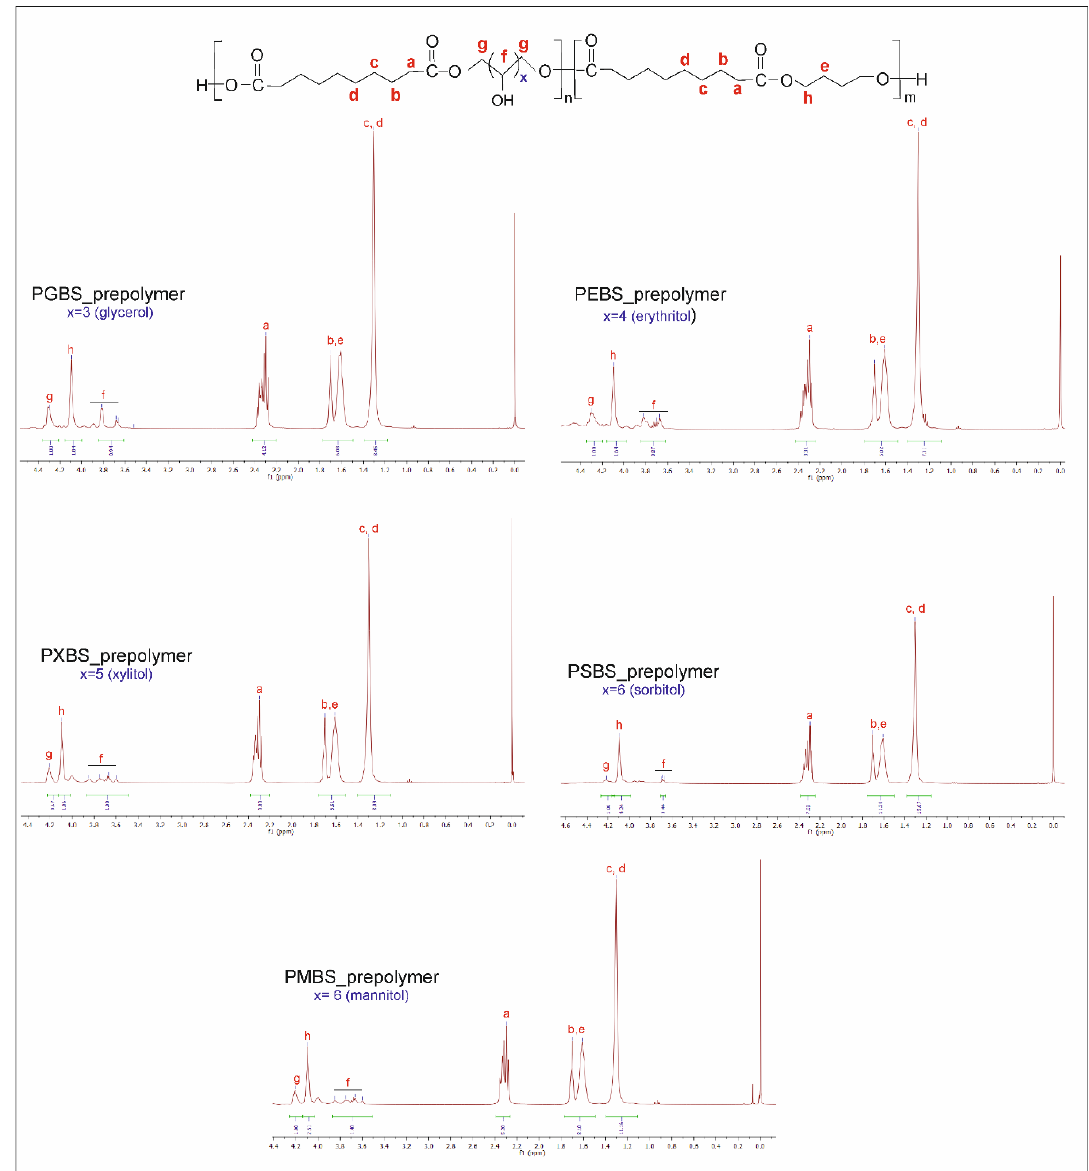
Figure 2. Nuclear magnetic resonance spectroscopy ( 1 H NMR) of poly(glycerol sebacate-co-butylene sebacate) (PGBS), poly(erythritol sebacate-co-butylene sebacate) (PEBS), poly(xylitol sebacate-co-butylene sebacate) (PXBS), poly(sorbitol sebacate-co-butylene sebacate) (PSBS), and poly(mannitol sebacate-co-butylene sebacate) (PMBS) prepolymers. The ratio of the area of the peak at 4.25 ppm to the area of the peak at 4.1 ppm tells us the reactivity of sugar alcohols as compared to butylene glycol. Erythritol is the most reactive, with the ratio of sebacic acid–butylene glycol ester bonds to sebacic acid–sugar alcohol ester bonds being 1.64,